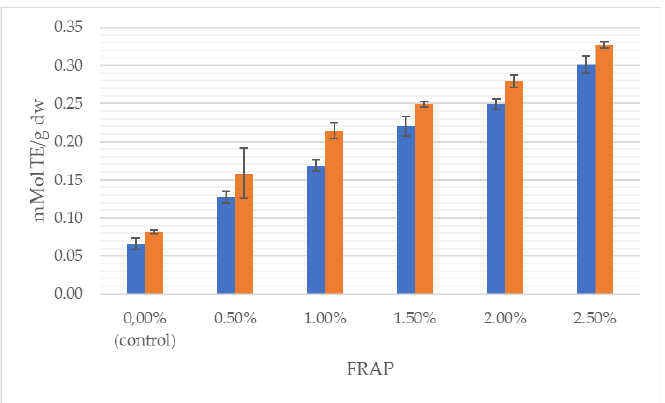
Figure 3. Antioxidant activity measured by ABTS method of wheat dough (blue bars) and bread (orange bars) enriched with J. regia male flowers.